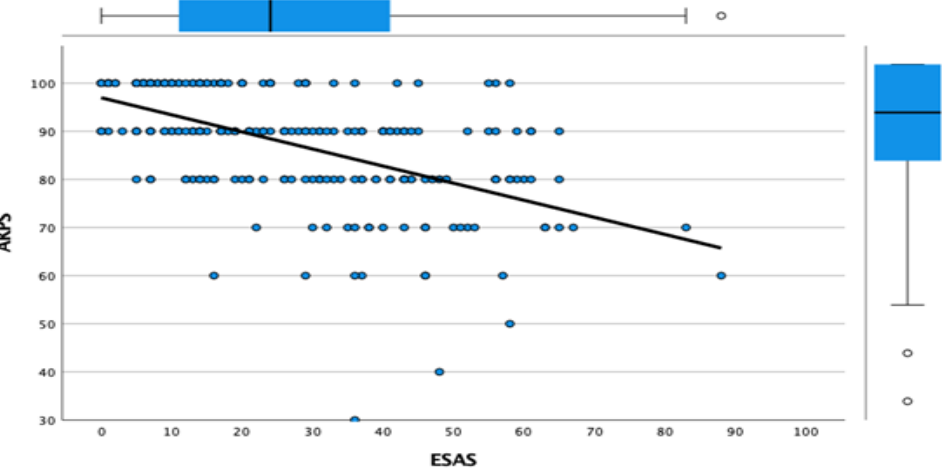
Figure 1. Liner regression of physical function and symptom severity. AKPS: Australia-modified Karnofsky performance scale, ESAS: Edmonton Symptom Assessment Scale.